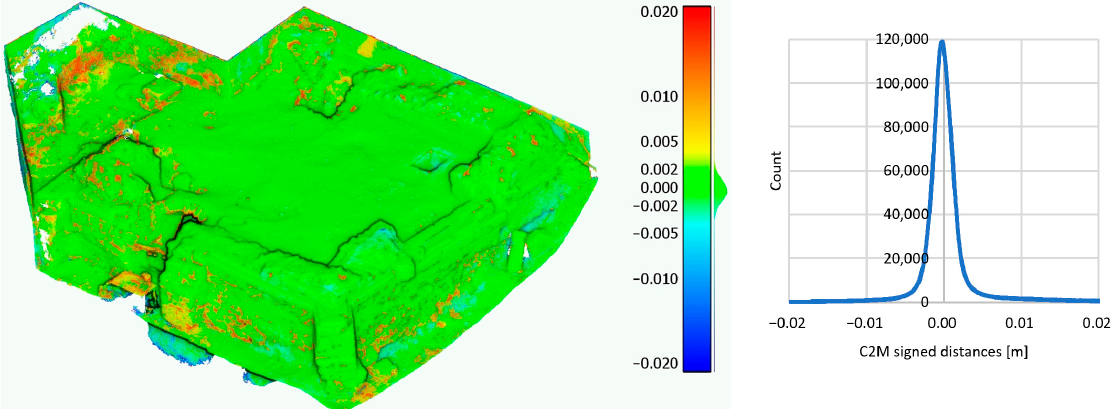
Figure 13. Deviations in the comparison of photogrammetry with all images active and the variant without connection through openings 2 and 3 (A vs. B) ( left ), and histogram of the deviations ( right ).